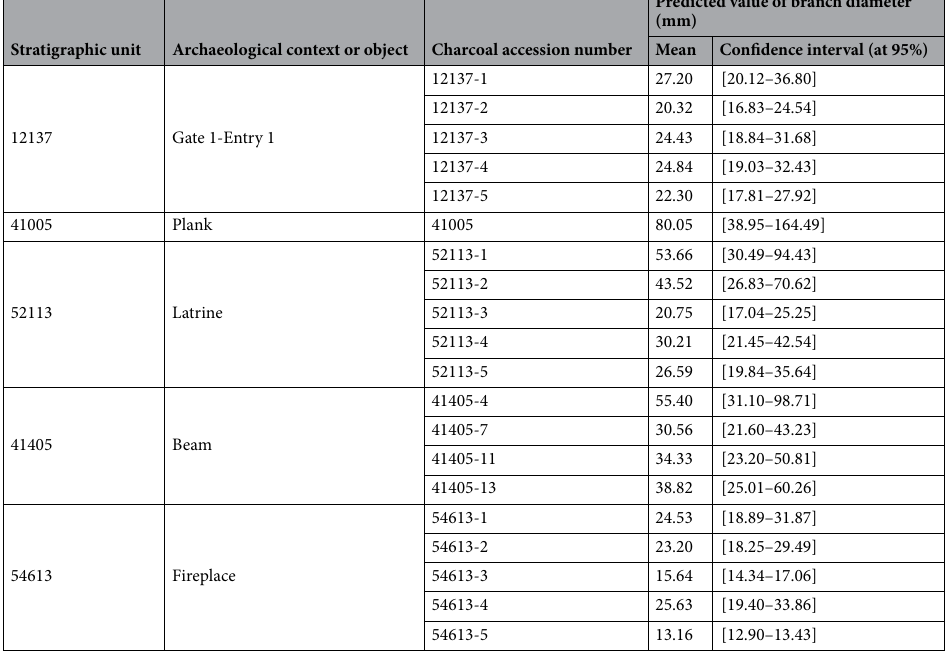
Table 1. Predicted value of branch diameter (mm) assessed using linear regression